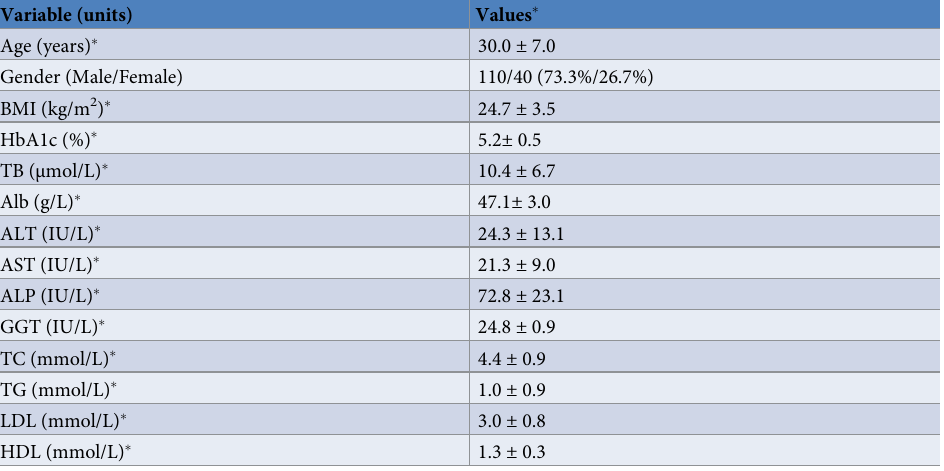
Table 2. Baseline characteristics of the study population (n = 150).